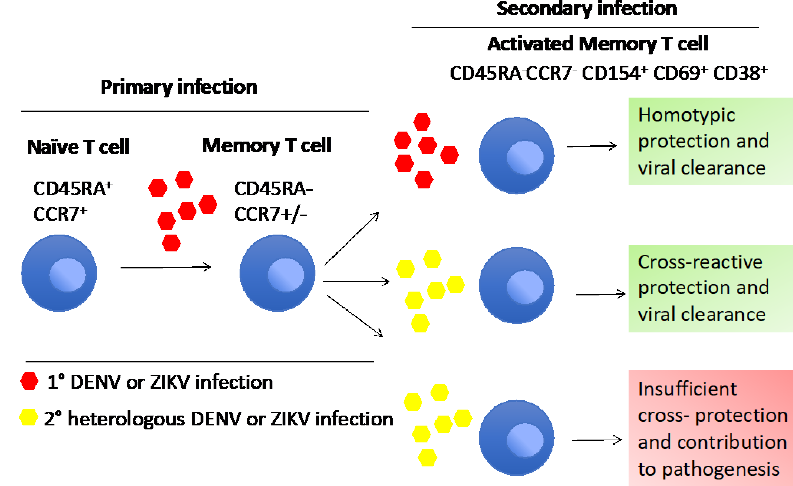
Figure 4. The dual role of T cells in flavivirus infection.